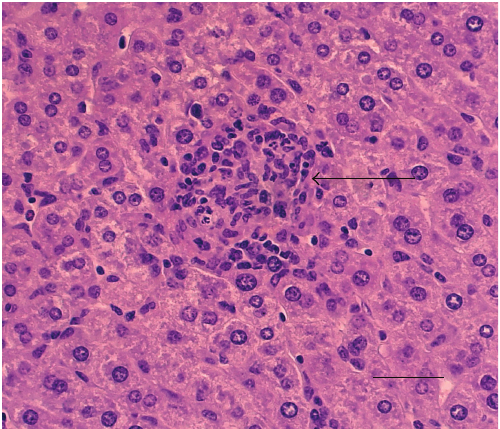
Figure 3: Liver of BALB/c mouse at 30 days of infection by Brucella ovis . The mouse was i.p. infected with 10 6 CFU of Bru- cella ovis ATCC25840. Microgranuloma containing predominantly macrophages and neutrophils (arrow). HE. Bar: 100 μ m.